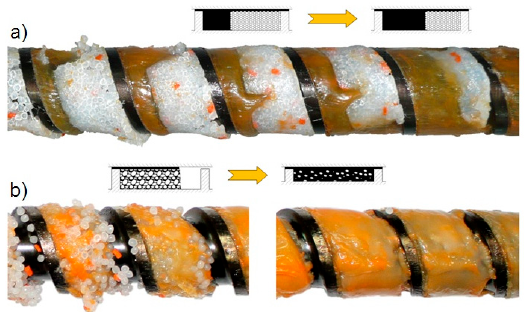
Figure 2. Mechanism of polymer melting in the single screw extruder on an example of extrusion of polypropylene: ( a ) flood fed extrusion, classical Tadmor mechanism, and ( b ) starve-fed extrusion, two-stage mechanism [46].